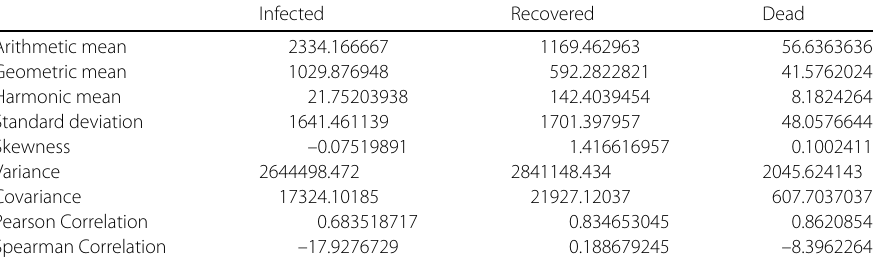
Table 2 Some data for coronavirus cases in Turkey